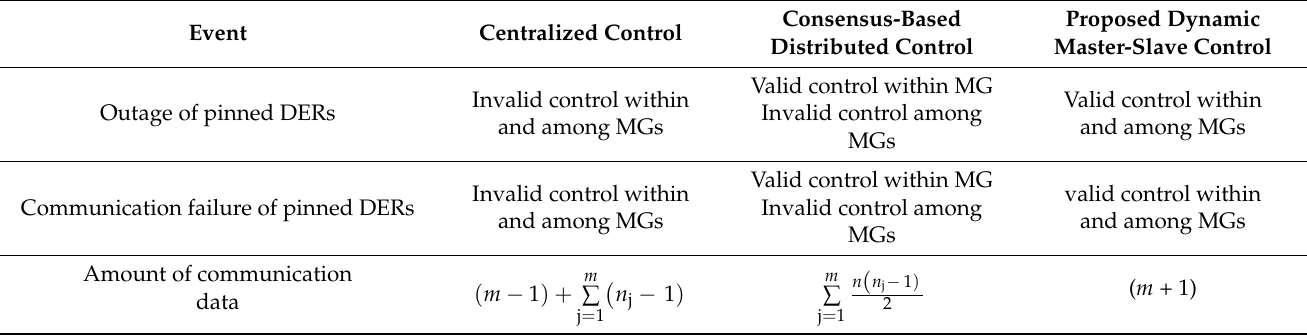
Table 1. Performance Comparison Among Conventional and Proposed